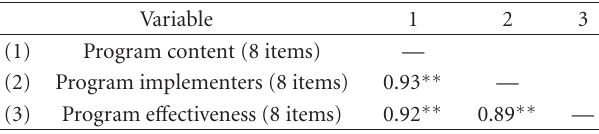
Table 7: Correlation coe ffi cients among the variables.